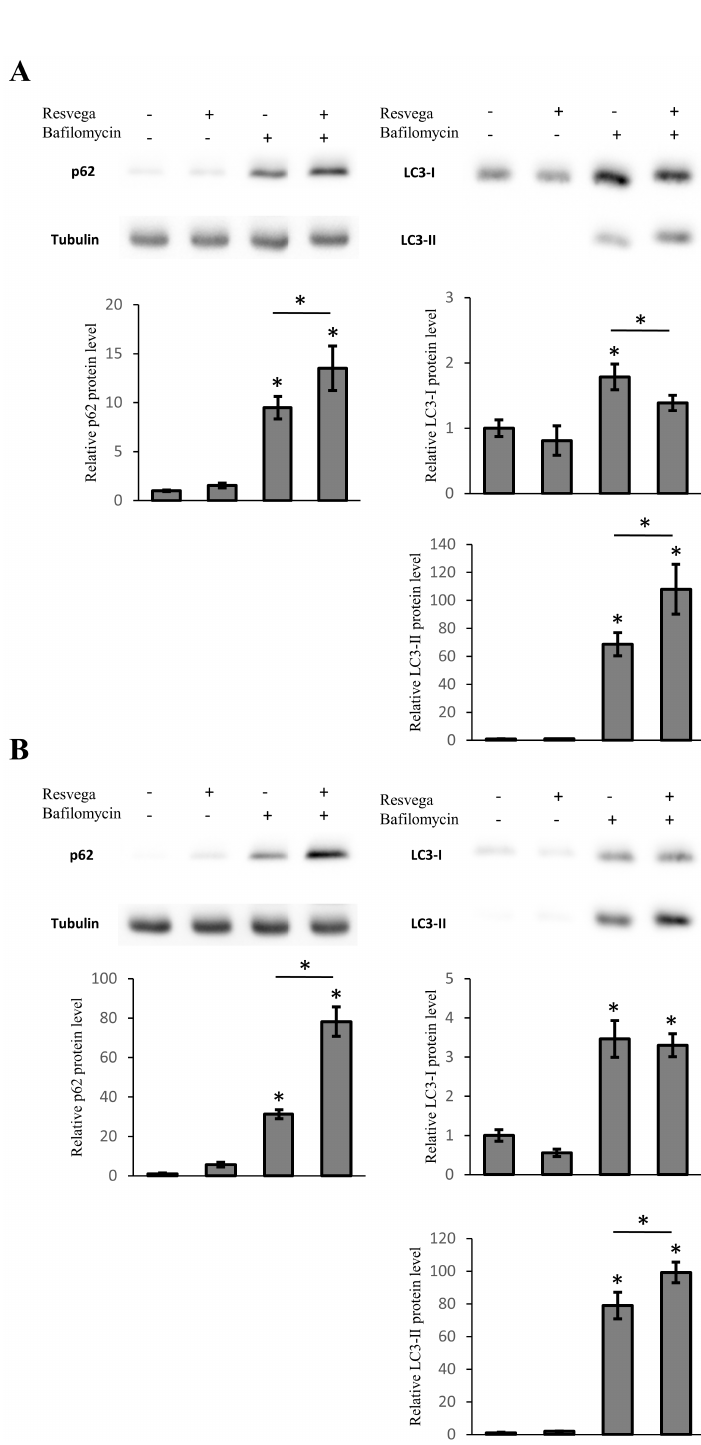
Figure 3. ARPE-19 cells were treated with 288 ng Resvega, 50 nM bafilomycin A1, or their combination for 12 h ( A ) in normal growth conditions and ( B ) a starvation-induced autophagy model. The protein level of p62 and LC3-I/LC3-II were analyzed by Western blot, while the expression was quantified in a comparison to α -tubulin and presented as a fold change compared to control. Western blotting data are shown as mean ˘ SD ( n = 3). * p < 0.05,